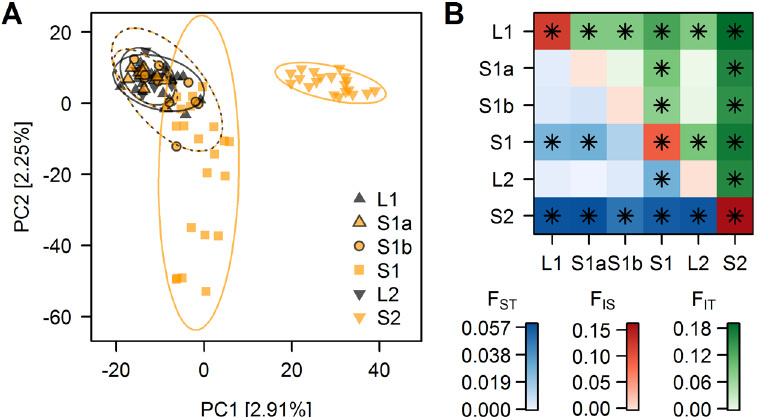
Fig 2. Genomic variation within and average differentiation between sampling sites. (A) Principal component analysis: PC1 separates site S2 individuals from the rest, while PC2 separates S1 individuals from the rest. Fill colors indicate the habitat in which individuals were caught, four stream habitat sites (orange) and two lake shore sites (black). PC analysis is based on the 24,784 SNP allele dataset with minor allele frequency > 1%. (B) F-statistics: between sampling sites pairwise weighted average F ST and F IT - statistics are shown below and above the diagonal respectively, F IS for each sampling site on the diagonal. Stars indicate values significantly different from zero (permutation test, > 16,000 permutations, p < 0.001). F- statistics are based on the 34,756 SNP genotype